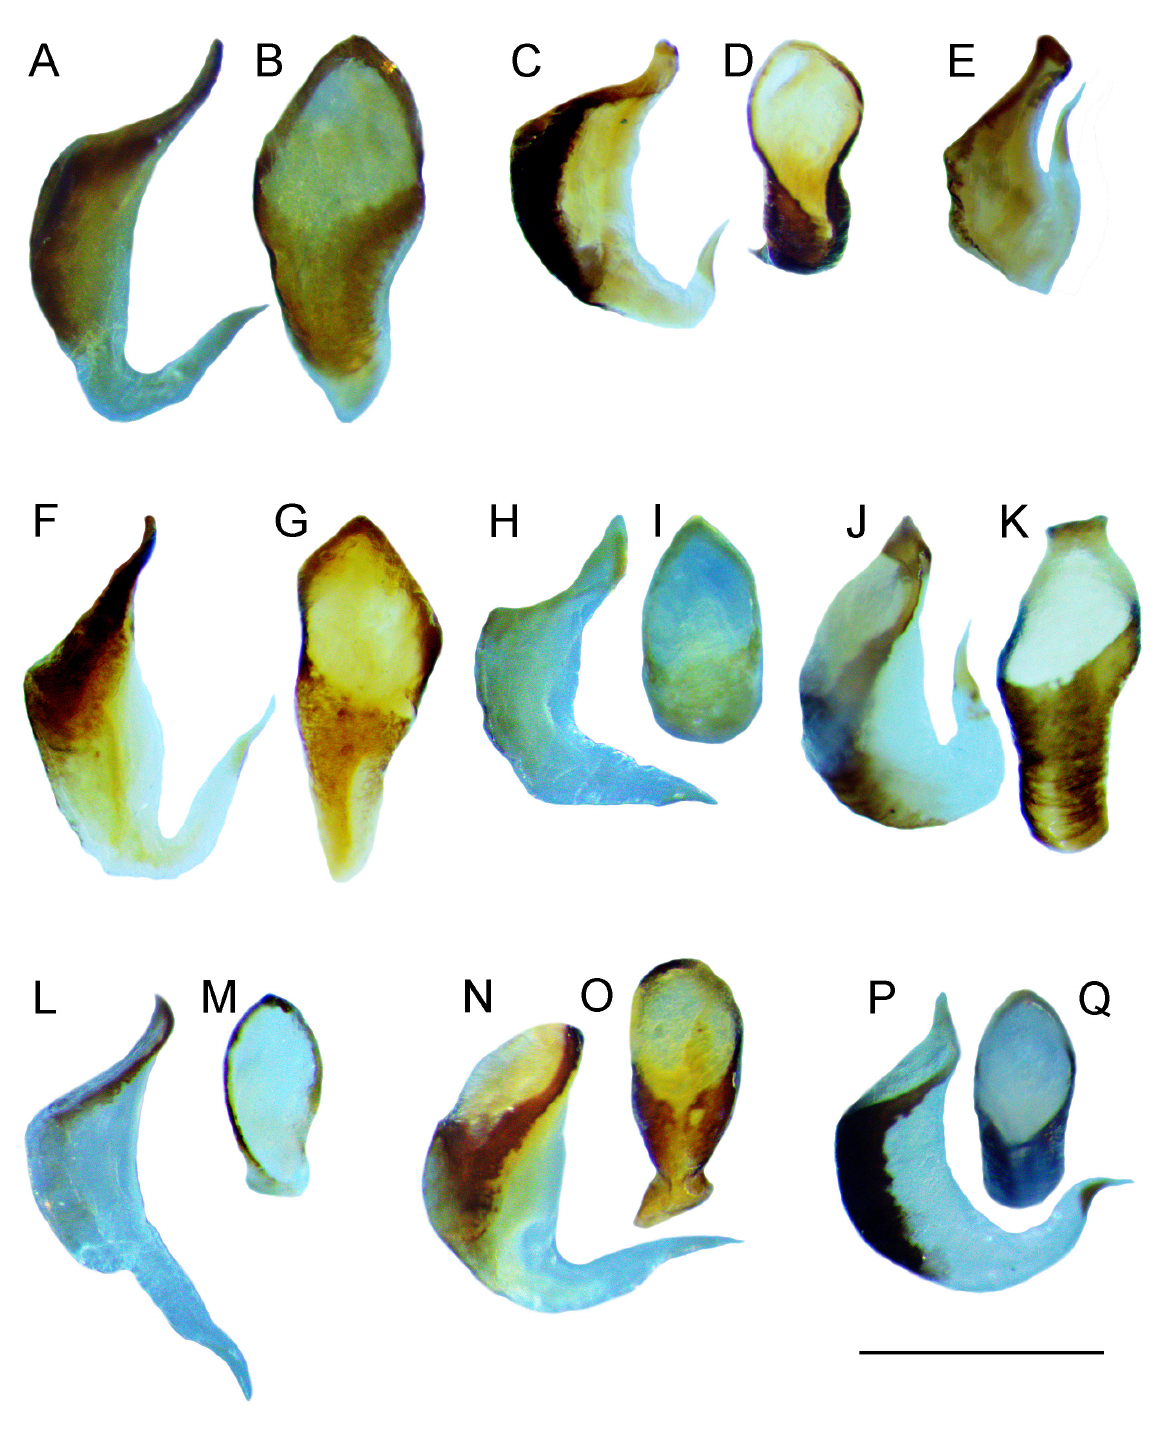
Fig. 17. Female genitalia in lateral (A, C, E, F, H, J, L, N, P) and dorsal (B, D, G, I, K, M, O, Q)